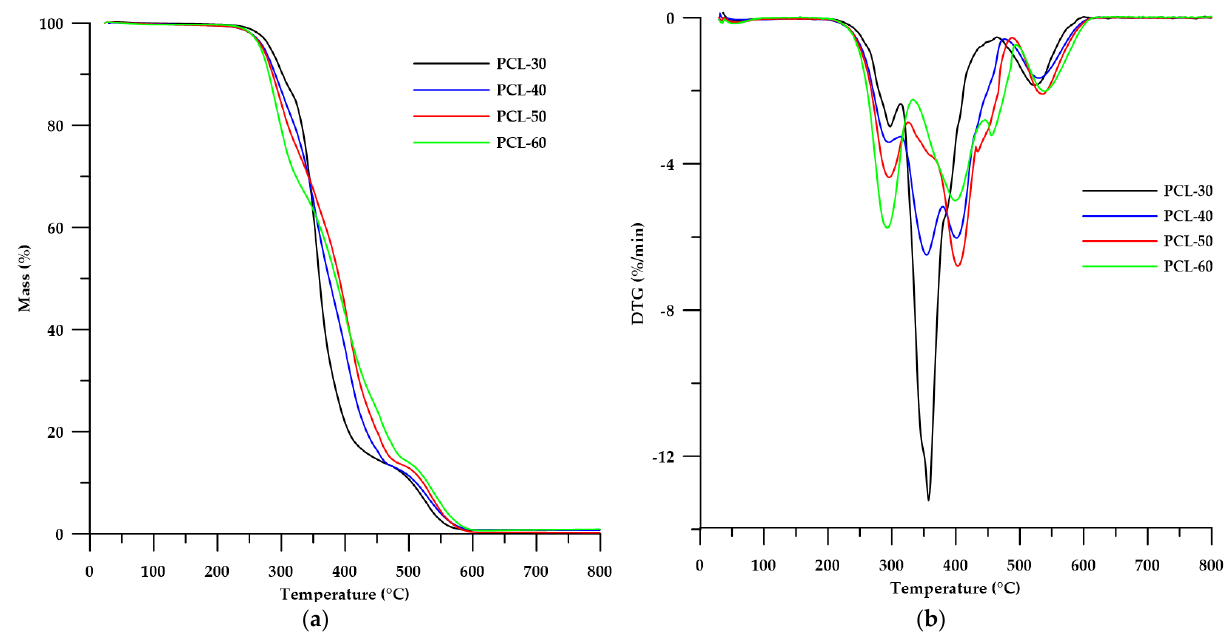
Figure 8. TG ( a ) and DTG ( b ) curves of the obtained polymers (in air).